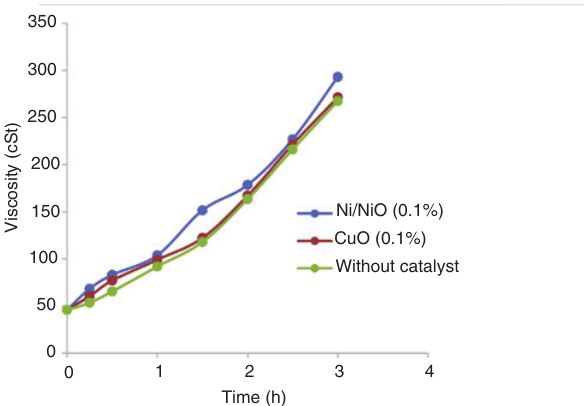
Figure 9: Soybean oil polymerization by Ni/NiO and CuO catalysts at 300 °